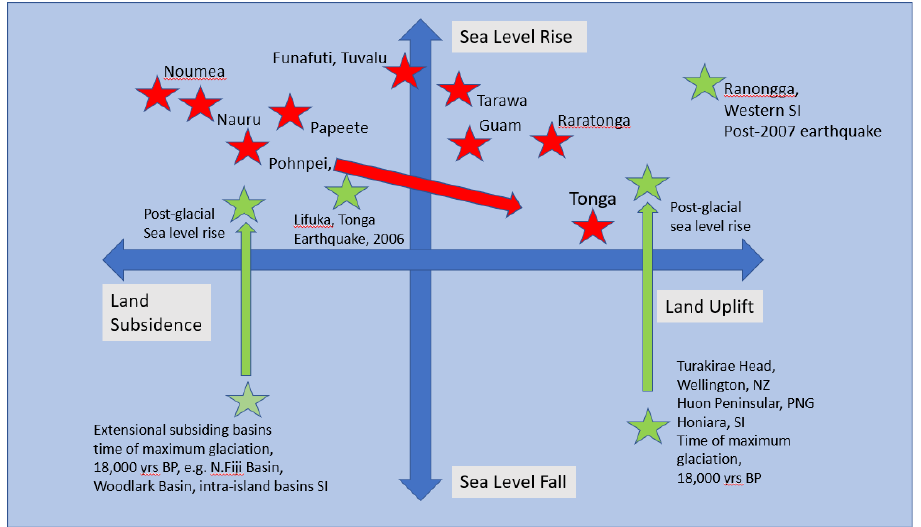
Figure 6. Graphical representation of land subsidence/uplift versus sea level rise and fall for the SW Pacific Region. NB: this is for generic discussion purposes only and does not constitute predictive patterns. Throughout geological time a dynamic interplay has existed with respect to tectonic and eustatic movements. Green symbols display events/situations dominated by tectonic uplift/subsidence with sea level rise and fall superimposed. Red stars indicate post 1950 relative positions of islands with respect to measured GPS and tidal gauge land/sea altitude variations. Diagram informed by Becker et al. [15]; Ballu et al. [16]; SPC, [17]; Taylor et al., [18]. SI = Solomon Islands, PNG = Papua New Guinea.